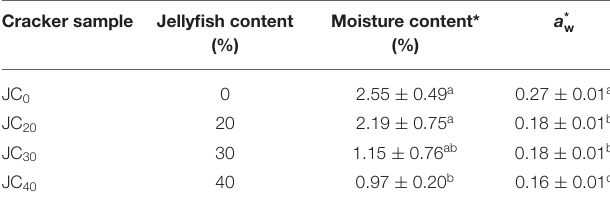
TABLE 2 | Moisture content and water activity of four jellyfish cracker